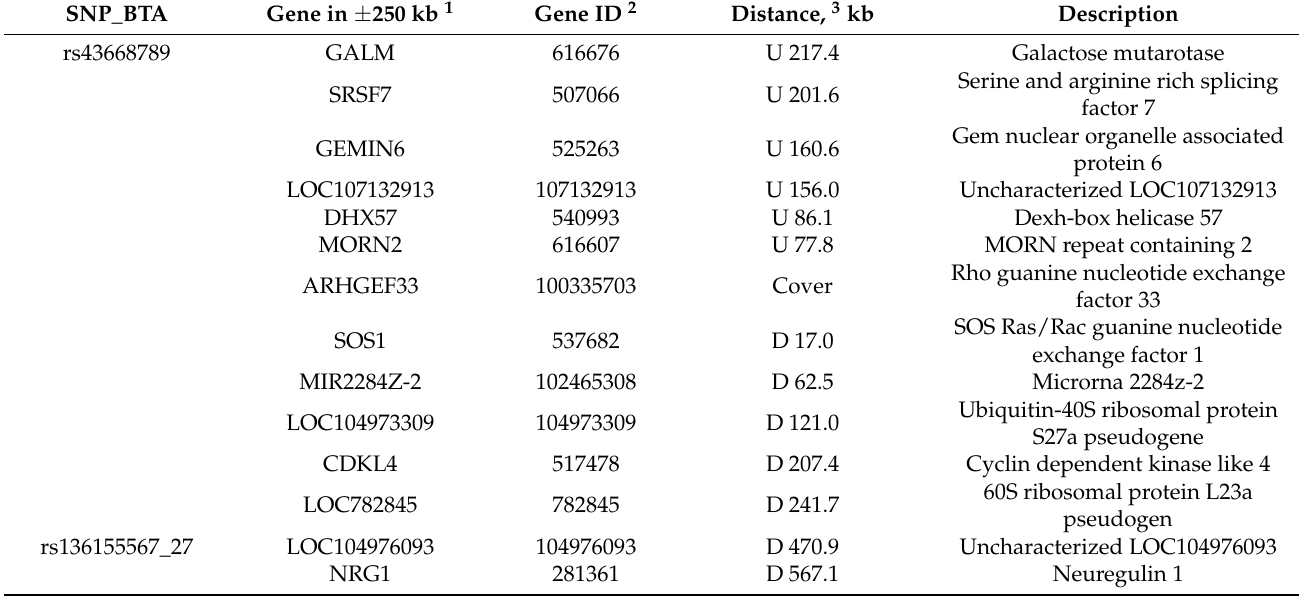
Table 5. Genes close to the SNPs associated to weaning weight of Braunvieh